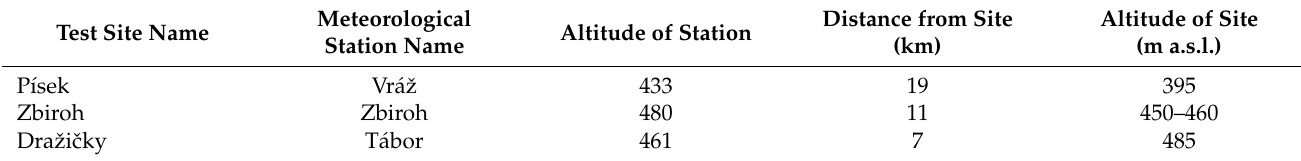
Table A1. Origin of climate data used for test sites.